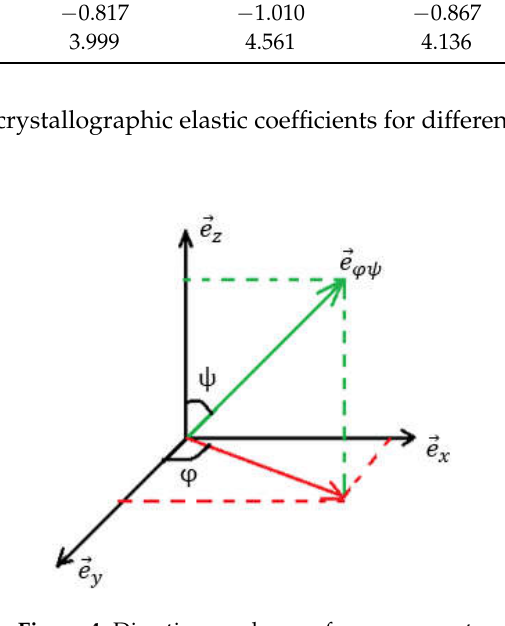
Figure 4. Directions and axes of measurement.